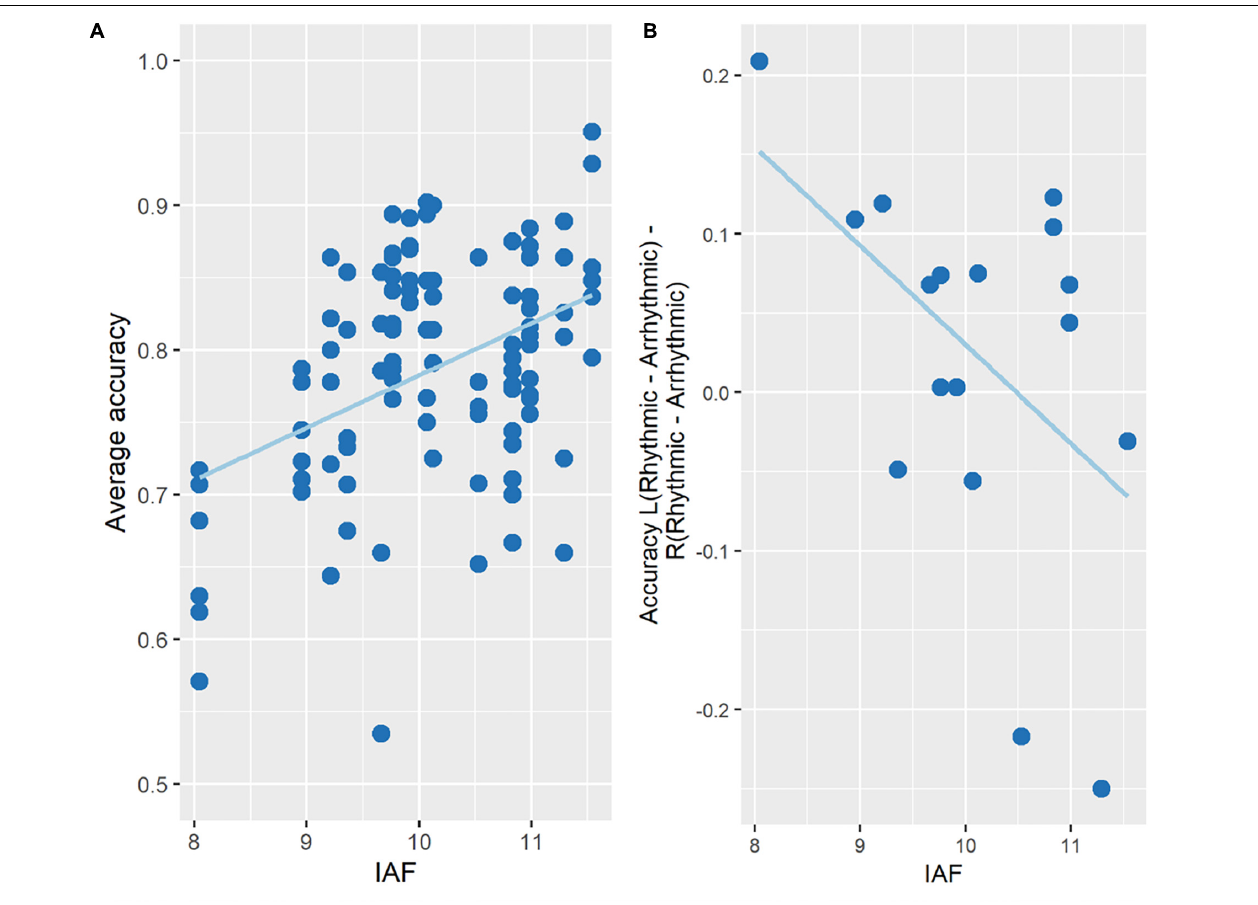
FIGURE 5 | Change in accuracy as a function of IAF. (A) A multiple regression analysis showed that accuracy increased with increasing IAF measured at rest across participants. The figure plots the experimental conditions (3 TMS conditions × 2 target locations) for each participant. (B) Spatially specific effects (LVF vs. RVF) of entrainment (10 Hz-TMS minus ar-TMS) as a function of IAF. Participants with lower IAF had accuracy increased by 10 Hz-TMS in the hemifield contralateral to the TMS site, hence benefitting from the 10 Hz-TMS stimulation, while the opposite effect can be seen in participants with high